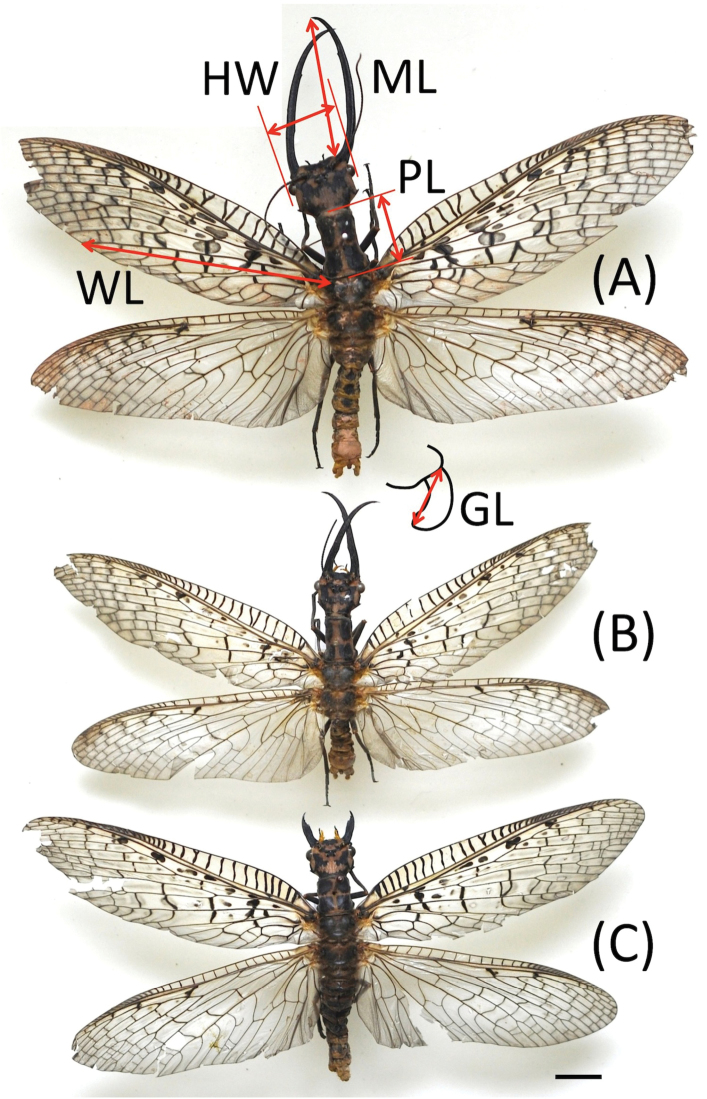
Acanthacorydalisasiatica in the dorsal view. A Large male B small male C female. Abbreviations: HW, head width; GL, genital (ectoproct) length in the lateral view; ML, mandible length; PL, prothorax length; WL, wing length. Scale bar: 10 mm.